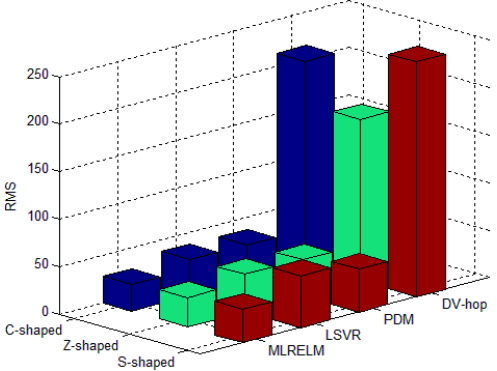
Figure 7. Average RMS for different algorithms in the regular deployment environment.